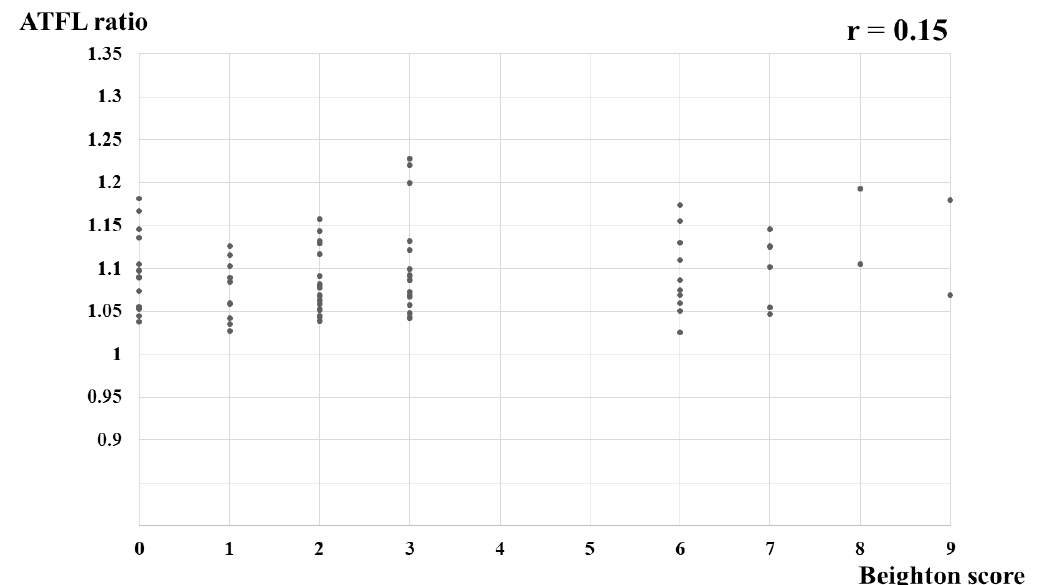
Figure 4. Correlation between the Beighton score and stress ATFL length in healthy young women. ATFL, anterior talofibular ligament.